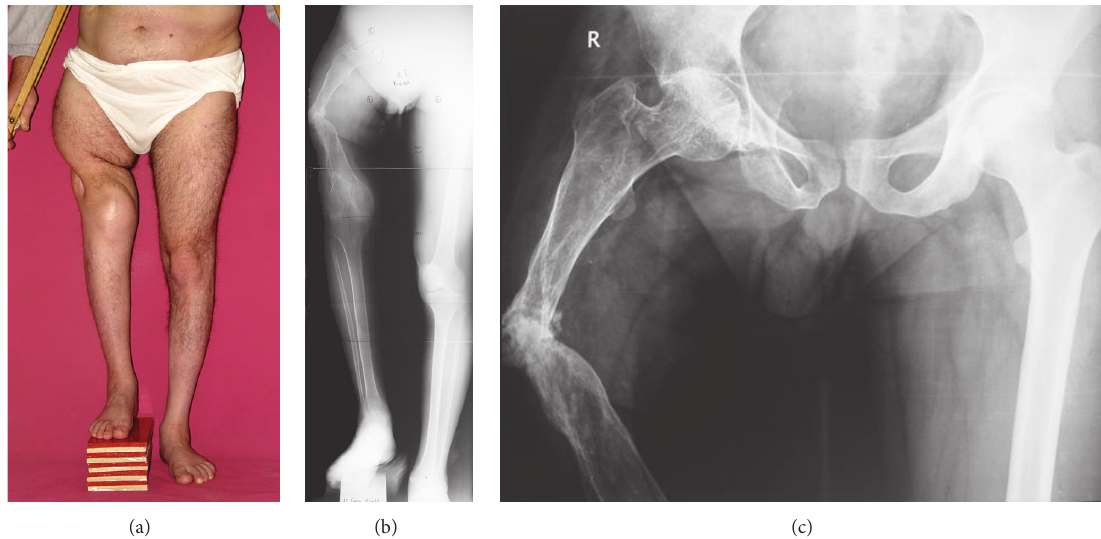
Figure 1: (a) Preoperative clinic appearance with 10cm length block under the right foot. (b, c) Preoperative radiographs. Note the nonunion and osteoporosis of the right